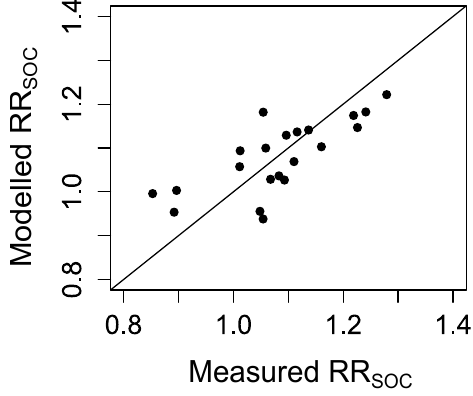
Figure 5. Measured versus modelled county-average car- bon concentration changes (RR SOC ) with model equation: RR SOC =− 0.04 + 0.29 × RR Ley + 0.38 × RR Manure + 0.17 × C Start − 0.8 × Organic farming